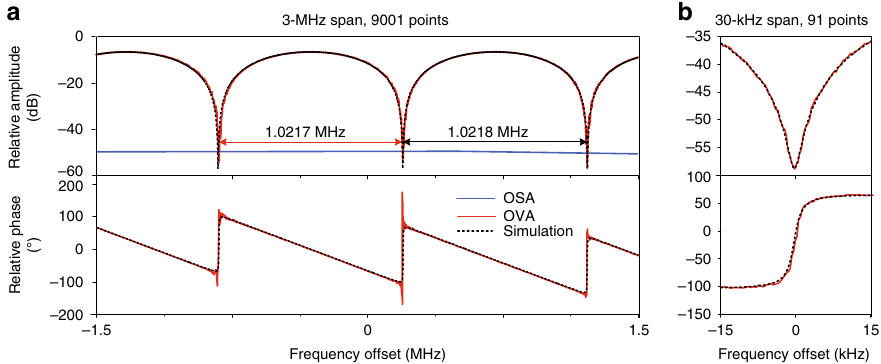
Fig. 5 The magnitude and phase responses of a fi ber Michelson interferometer. a The measurement results in a span of 3 MHz with 9001 points, showing a free spectral range (FSR) of 1.0217 MHz. b The measurement results in a span of 3 kHz with 91